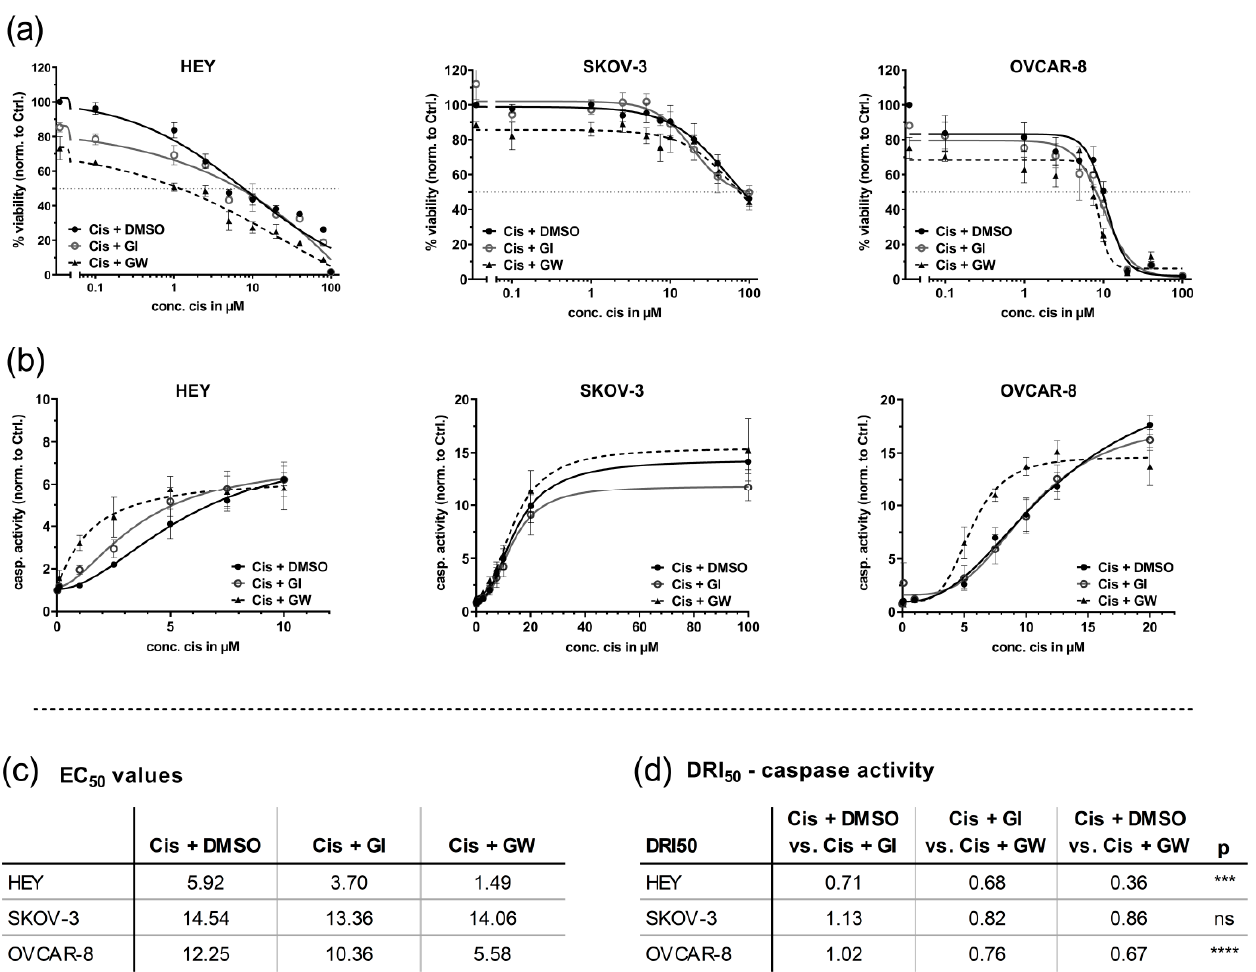
Figure 4. In spheroids of OvCa cell lines, GW280264X plus cisplatin led to a higher cytotoxic effect in HEY and OVCAR-8 cells compared with cisplatin alone. HEY, SKOV-3, or OVCAR-8 cells were seeded in ULA plates with pre-investigated cell densities of 300, 6500, and 4000 cells, respectively, to reach similar spheroid diameters on the day of treatment. On day four after seeding, cells were treated with the indicated concentrations of cisplatin (cis) or NaCl solvent control. For ADAM17 inhibition, GW280264X was used. GI254023X was applied to inhibit ADAM10 and DMSO was used as the solvent control. Curve fitting was performed using GraphPad Prism and EC 50 values were calculated from each curve of DMSO, GI254023X (GI), and GW280264X (GW), setting the response of each individual curve (0 µ M cis) to the lower (EC 50 ) baseline value for calculation. ( a ) Quantification of viable cells by the RealTime-Glo™ Assay 48 h after treatment (means of technical replicates ± SD are displayed). ( b ) Apoptosis was measured using the Caspase-Glo ® 3/7 reagent. Data of at least three biological replicates were normalized to the control (DMSO, NaCl) and are presented as mean ± SEM. Graphs are displayed until the concentration of cisplatin reached the upper plateau. ( c ) EC 50 values of caspase3/7; ( d ) drug reduction index (DRI 50 ) at 50% effectiveness: DRI 50 represents, e.g., the cisplatin concentration required in combination with GW compared with cisplatin alone (to reach 50% effectiveness): synergistic (DRI 50 < 1), additive (DRI 50 = 1), and antagonistic (DRI 50 > 1) effects. ns: not significant, *** p < 0.001, **** p <